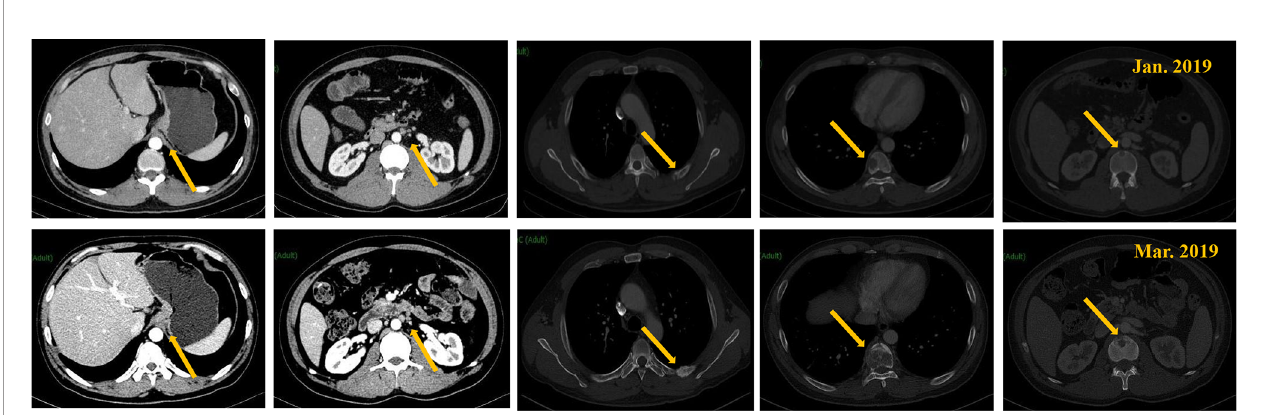
FIGURE 1 | CT scan of the tumors before and after fi rst-line